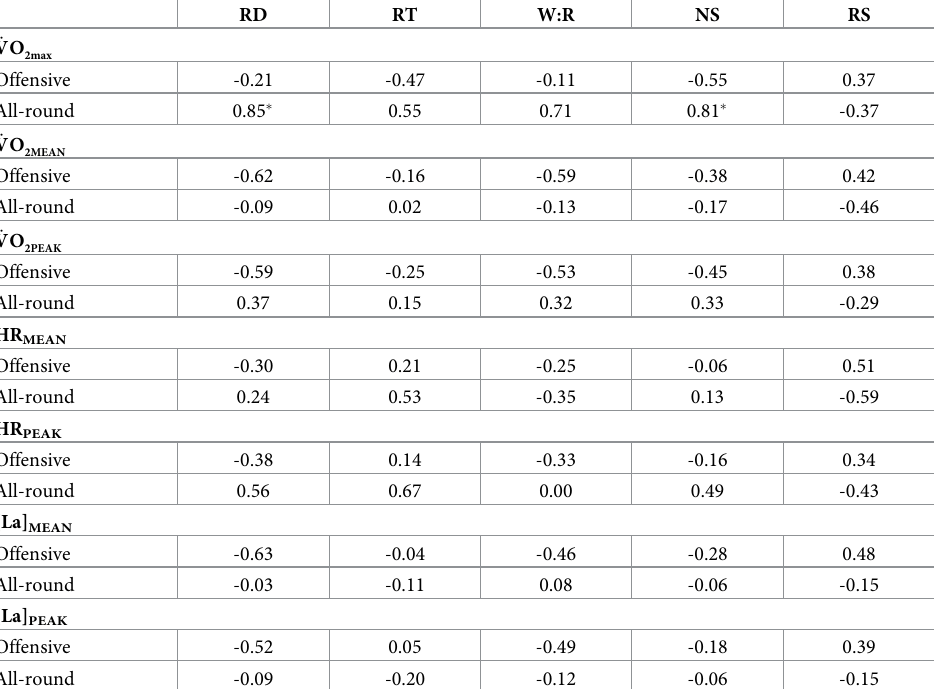
Table 3. Pearson’s correlation (r) between physiological variables and temporal variables analyzed by playing